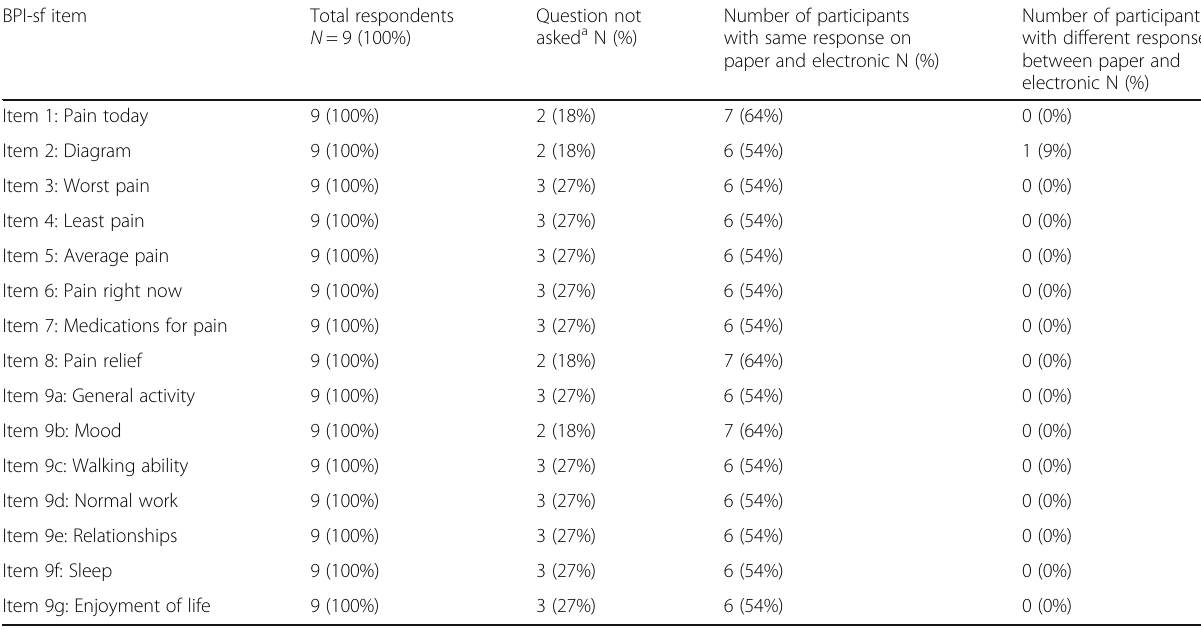
Table 4 Comparison of Responses on BPI-sf Electronic vs. Paper Formats: Pleural Participants ( n = 9) BPI-sf